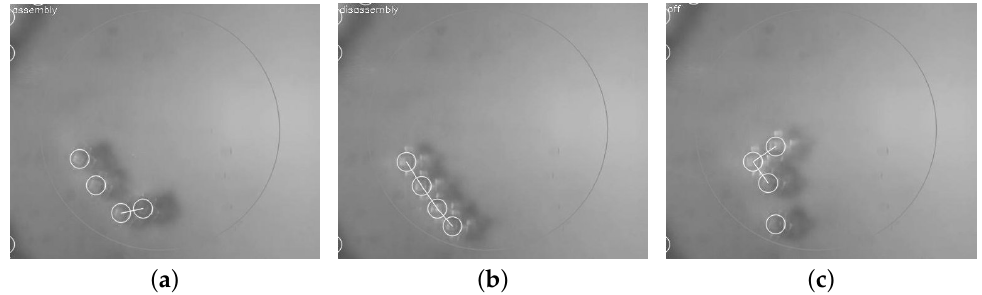
Figure 9. Self-assembly sequence for target cluster of size: three [10]. ( a ) 2.00 s, assembly mode; ( b ) 2.80 s, disassembly mode; ( c ) 3.92 s, target structure